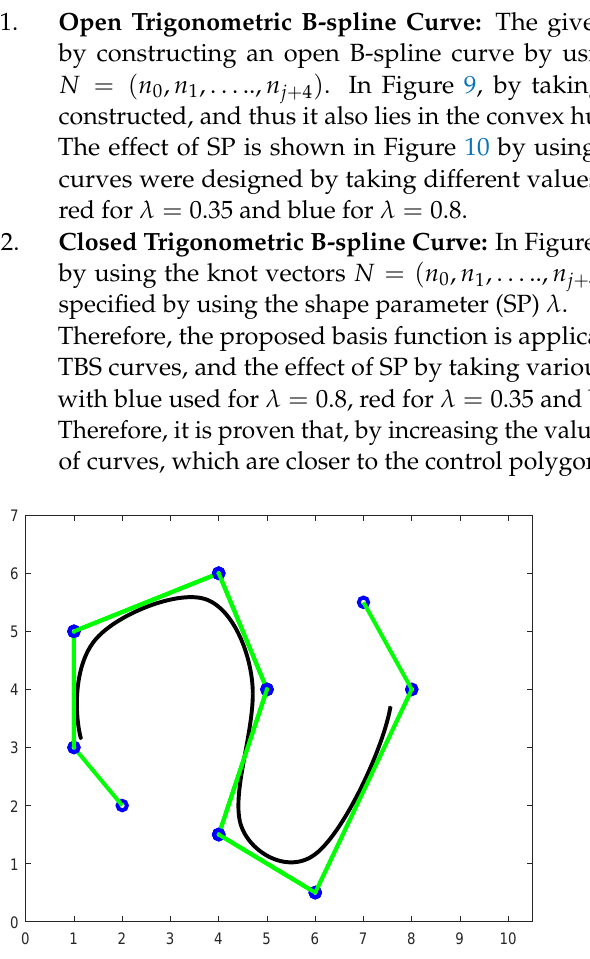
Figure 9. Open curve using CTBS basis